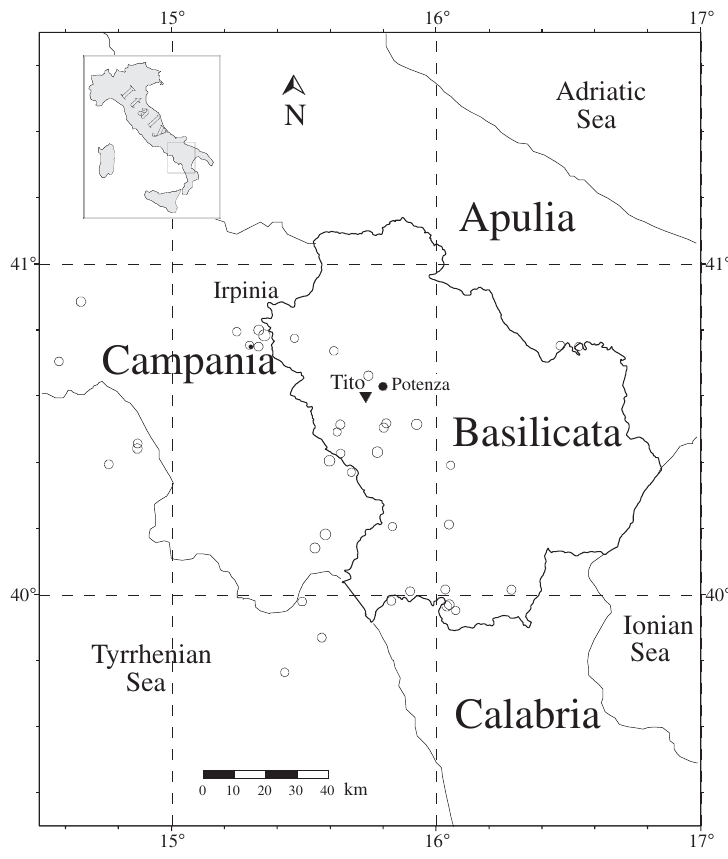
Fig. 1. Location of the geoelectrical monitoring station Tito in Southern Apennine Chain. The epicentral dis- tribution of the events occurring during the measurement period is also